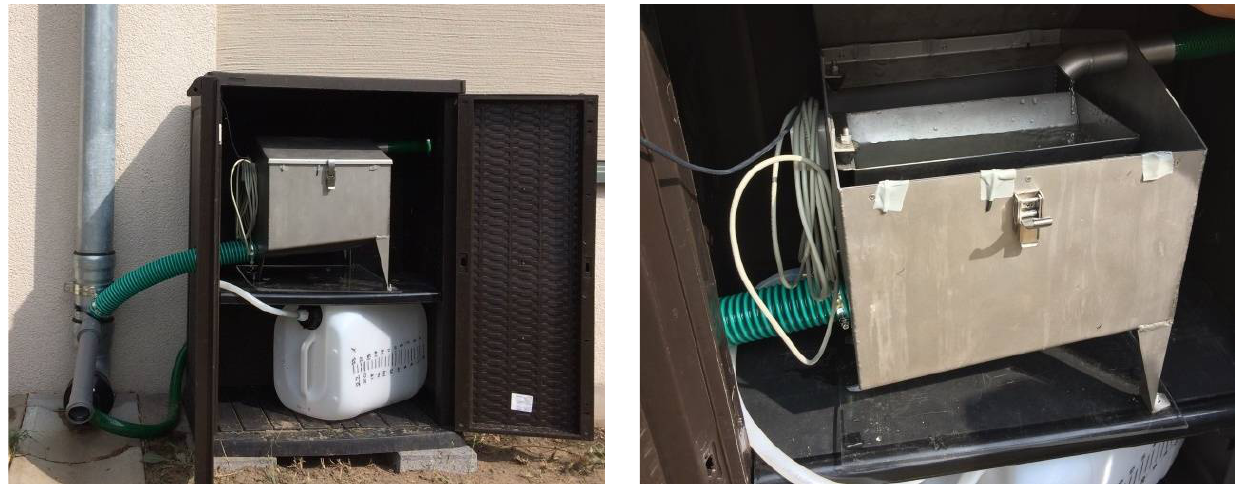
Figure A3. Tipping counter for measurement and sampling of roof runoff.